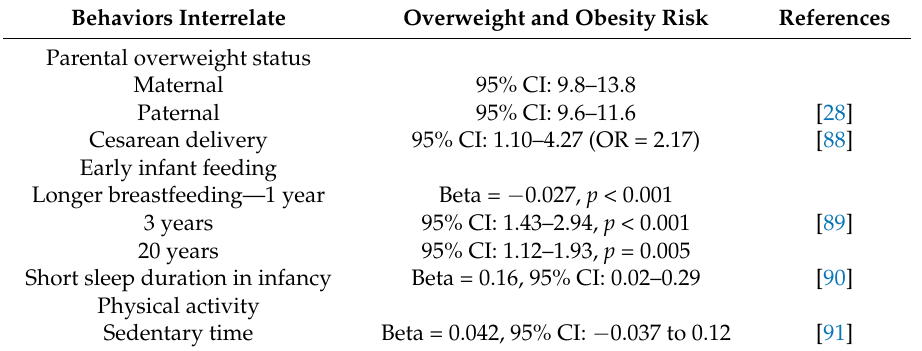
Table 2. Association between interrelate behaviors and overweight and obesity in